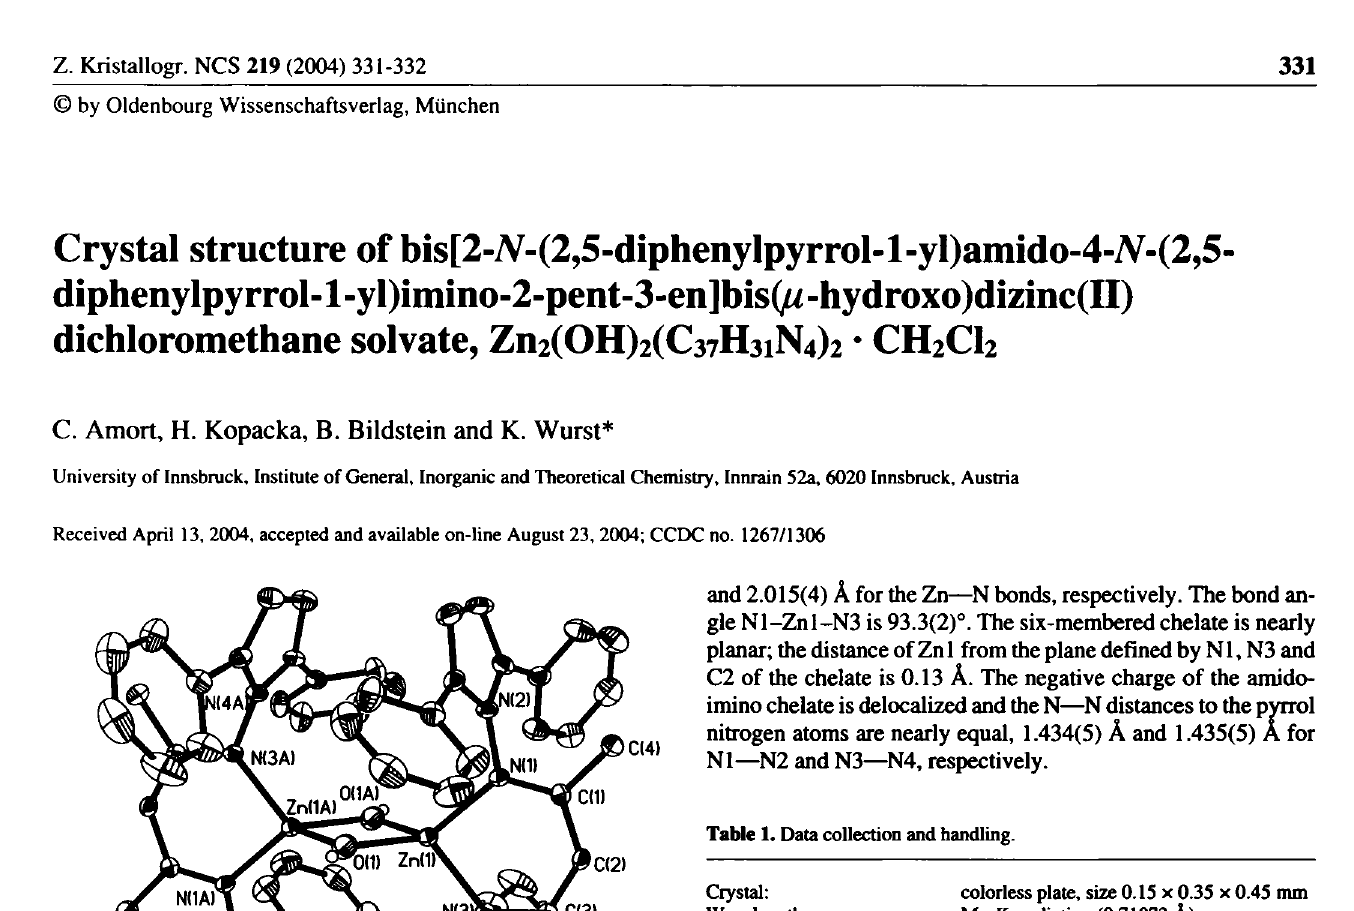
Table 2. Atomic coordinates and displacement parameters (in Â 2